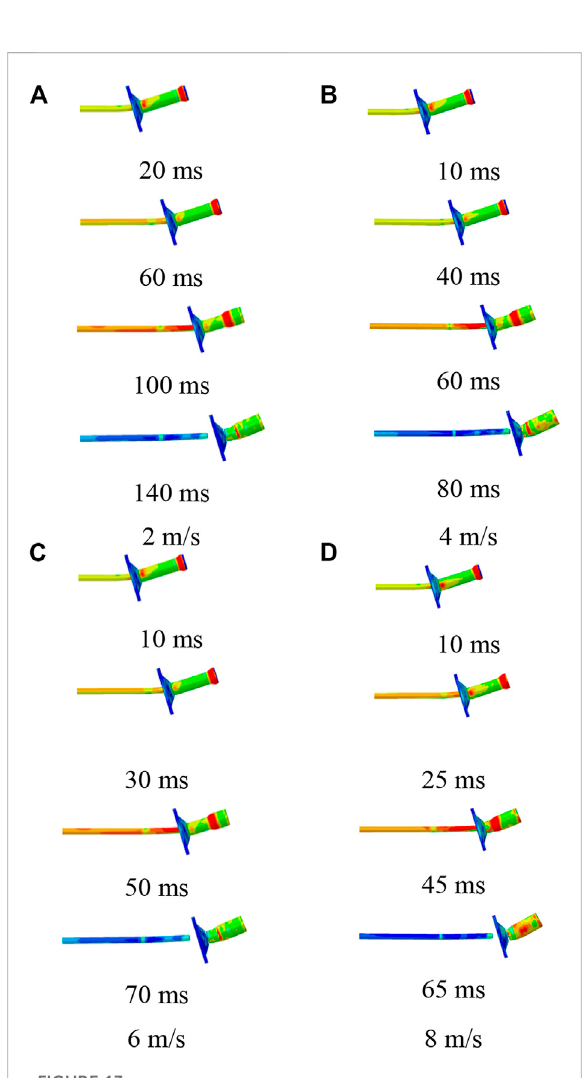
FIGURE 13 Deformation of bolt with time at different impact